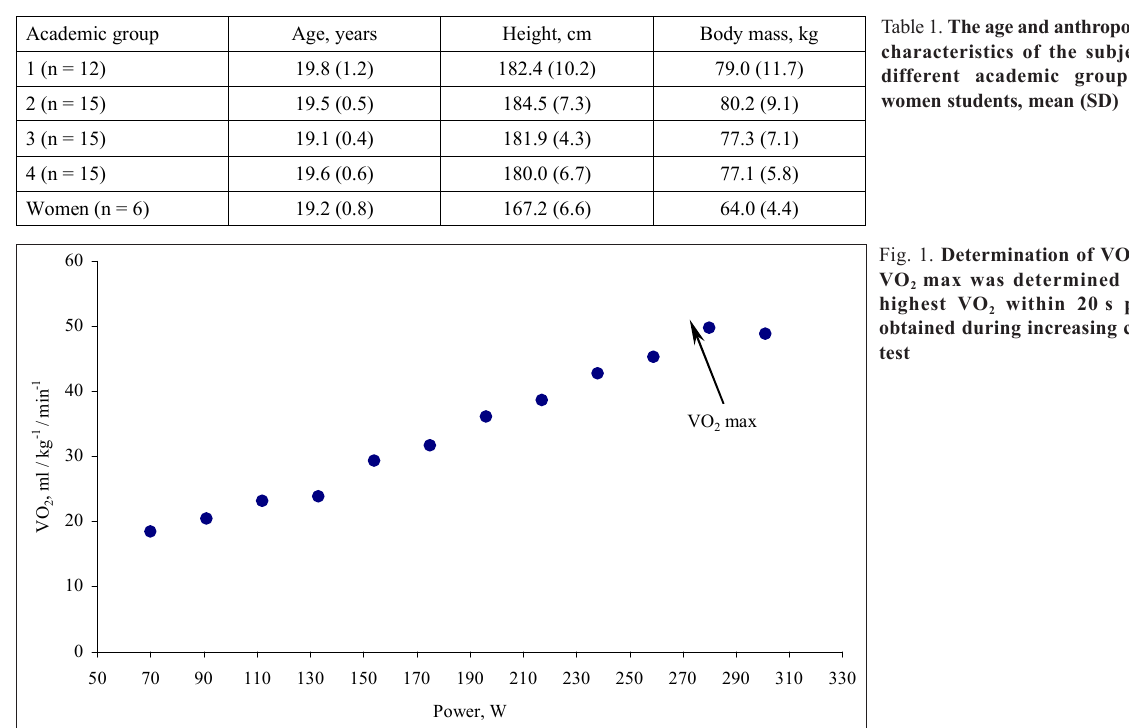
Table 1. The age and anthropometric characteristics of the subjects in different academic groups and women students, mean (SD)